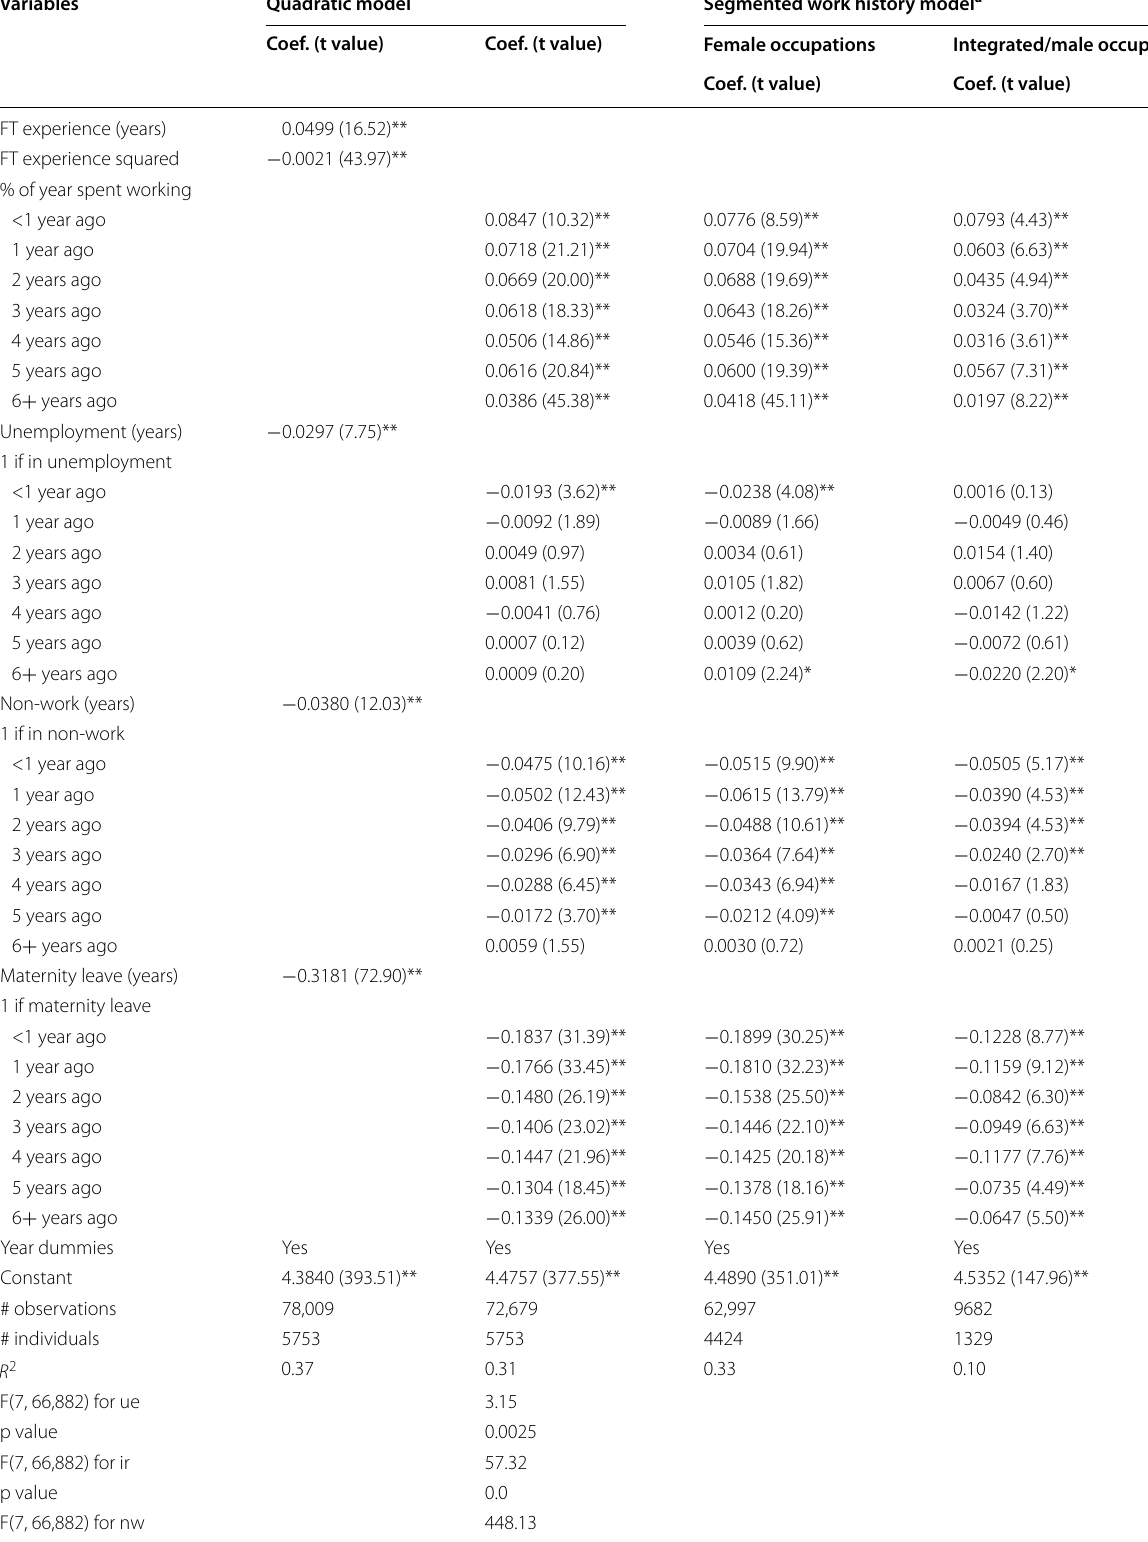
Table 2 Fixed effects estimates of wage equations, 1981–1997 IABS data female young